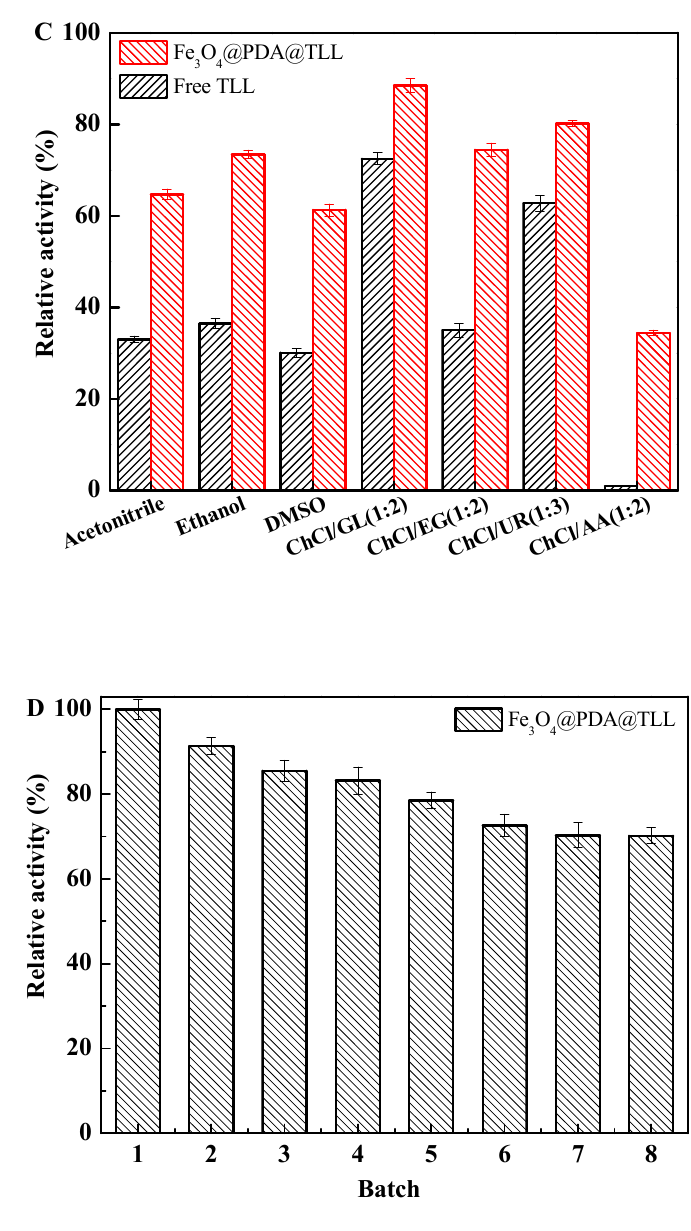
Figure 6. pH ( A ), thermal ( B ), solvent tolerance ( C ), and operational ( D ) stabilities of the enzyme.